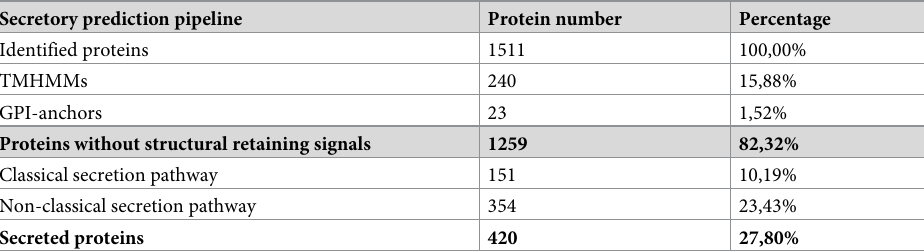
Table 2. Protein secretion pipeline applied to the D . vitifoliae salivary gland